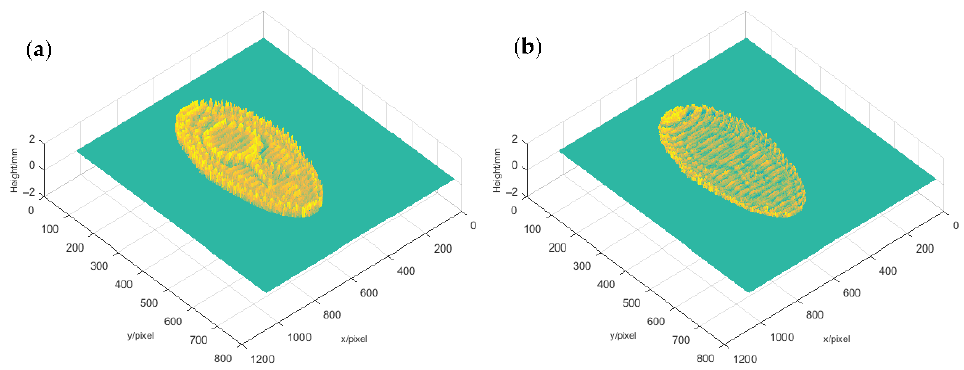
Figure 8. Comparison height error distributions: ( a ) traditional color PMP; and ( b ) the proposed